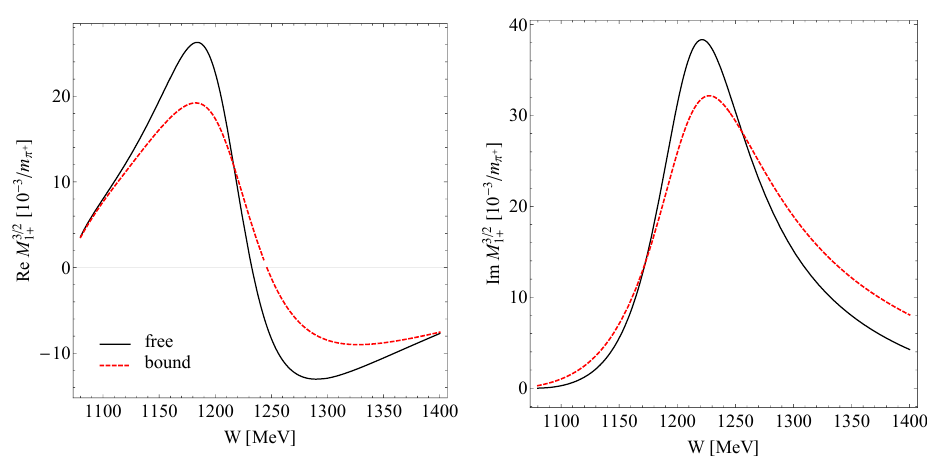
magnetic multipole am- 1 +